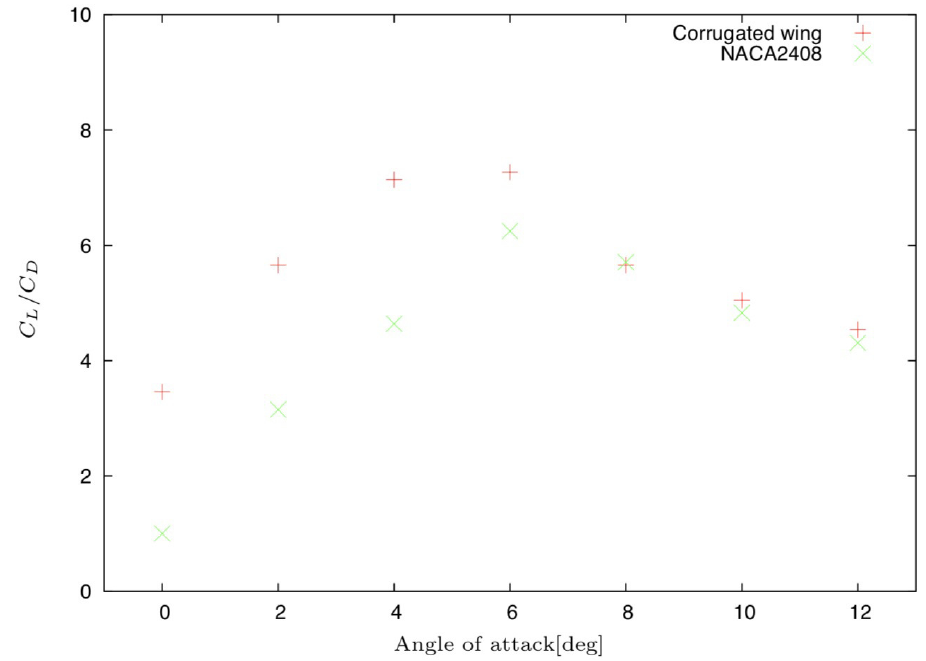
Figure 17. The mean lift-to-drag ratio of the 3D calculation for the corrugated airfoil and the 3D profiled NACA2408 airfoil at Re = 4000 with varying angle of